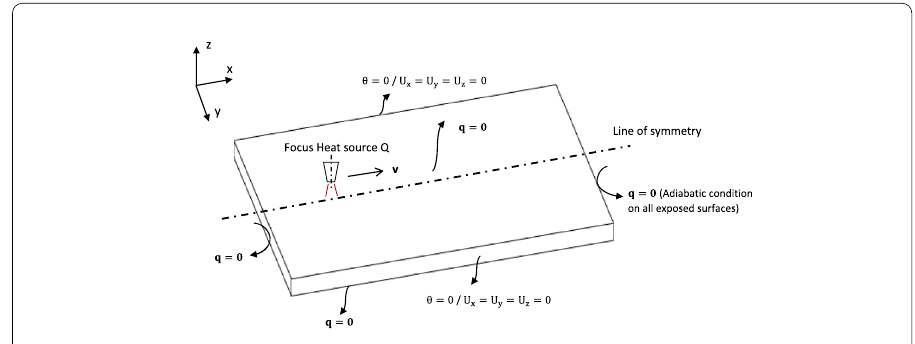
Fig. 5 Welding work-piece: geometry and boundary conditions